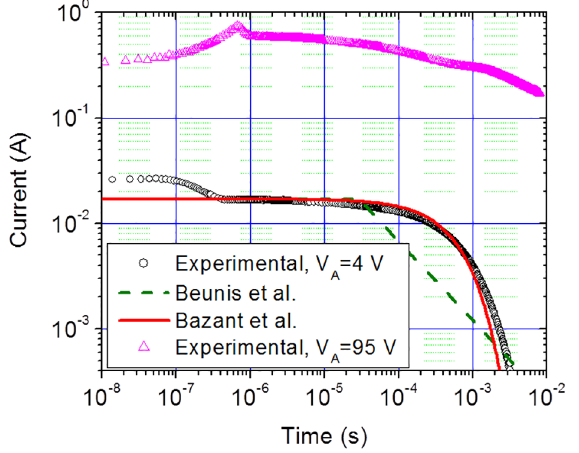
Figure 6. The effect of electrode type on current response of a lysis chamber. Two electrical lysis chambers, made respectively with copper and SEB electrodes, were filled with the microbial cell suspensions having ionic strength of 0.5 mM. Bipolar square pulses with amplitude of 195 V were applied and the electric current was